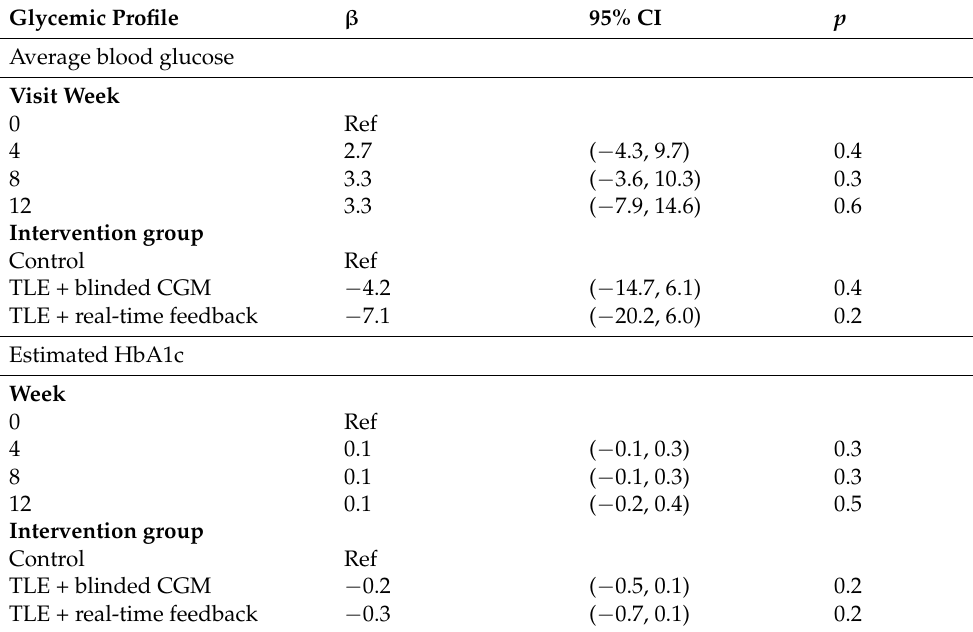
Table 5. Mixed-effects generalized linear model of the glycemic profile change extracted from CGM